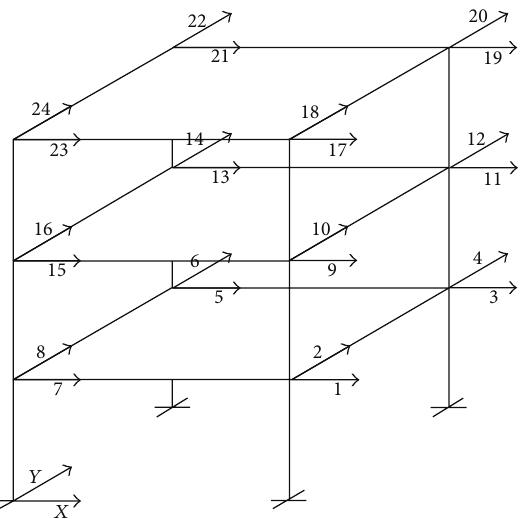
Figure 2: Location of the sensors on the building.